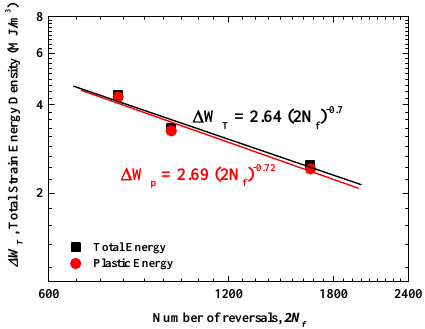
Figure 11. Fatigue life curves based on total and plastic strain energy dissipated per cycle of Alloy 617 at the 950 °C condition.